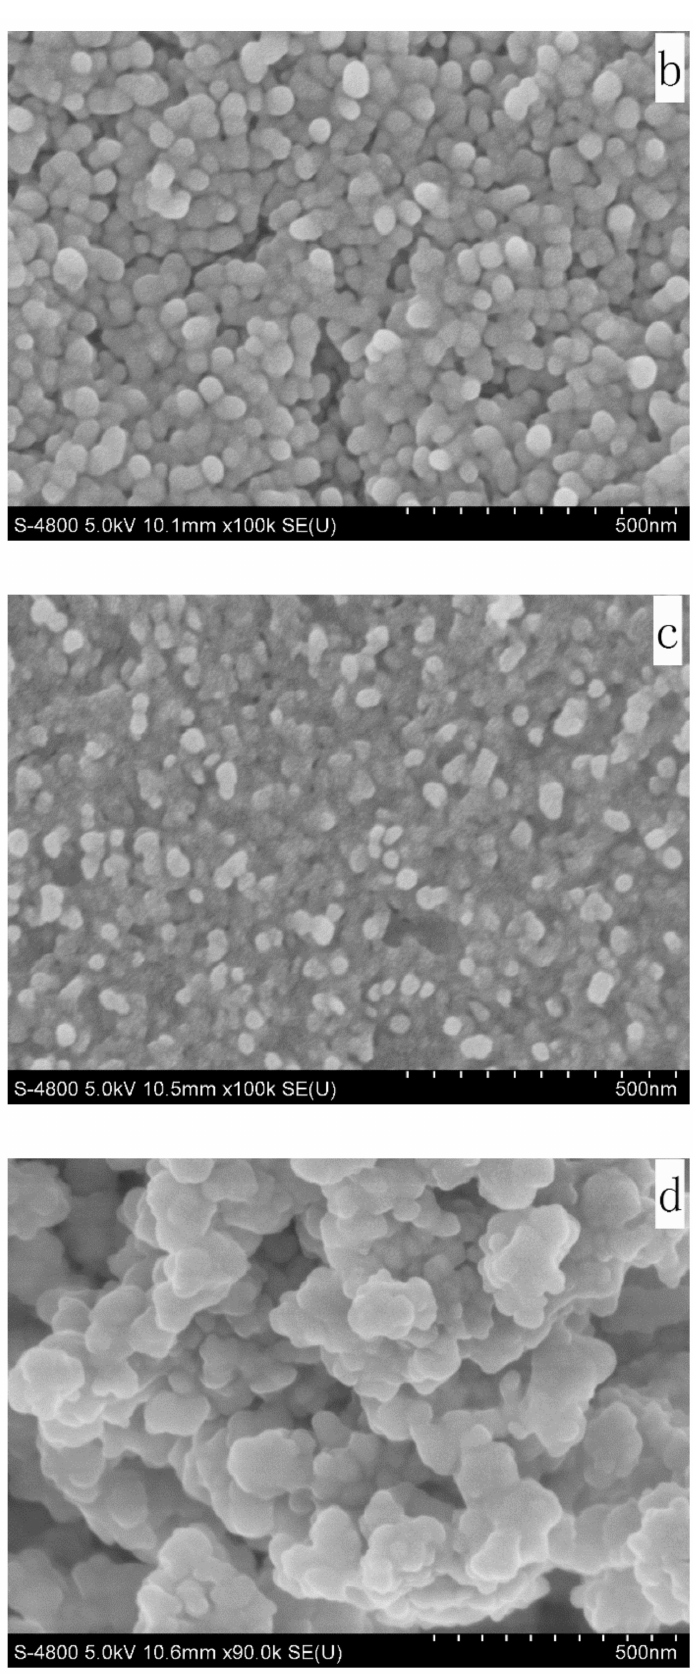
Figure 3. SEM of un-( a ) 3% ( b ) 6% ( c ) 12% ( d ) Ce-doped ( b ) ZnO thin